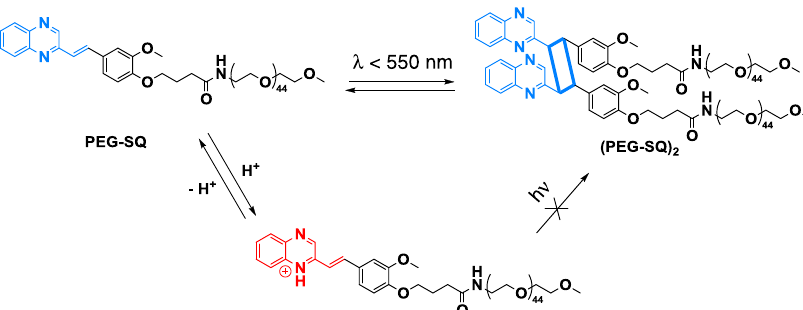
Fig. 1 Schematic representation of the proposed reaction mechanism. [2 + 2] Photocycloaddition of PEG-styrylquinoxaline